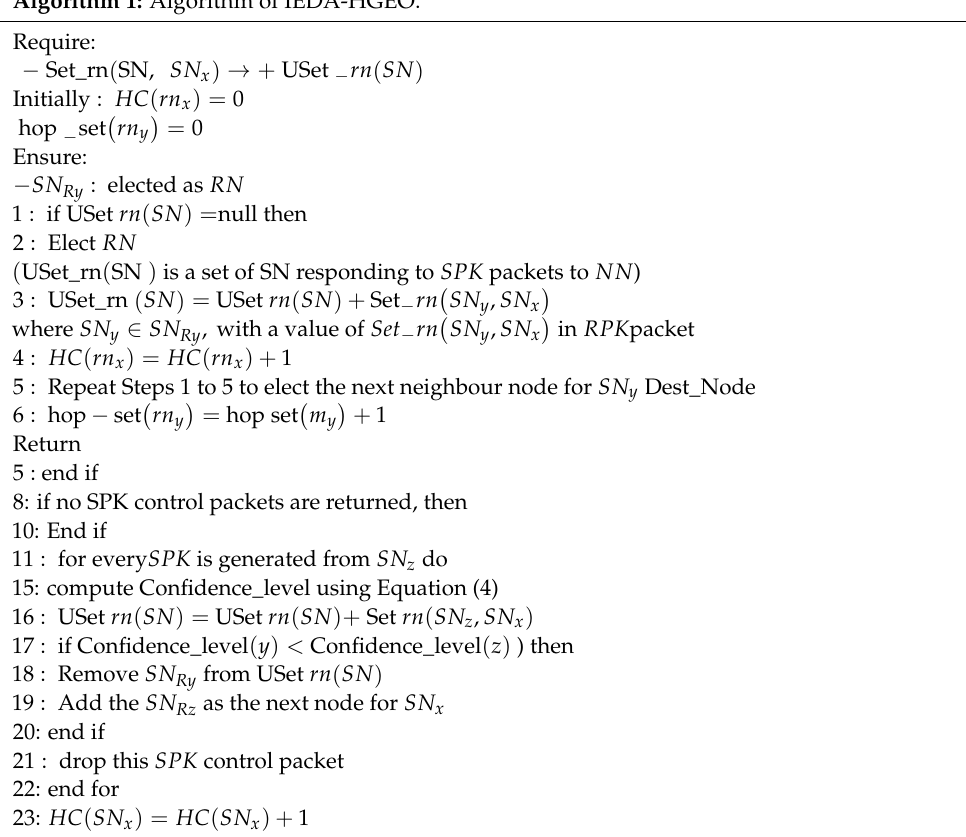
Algorithm 1: Algorithm of